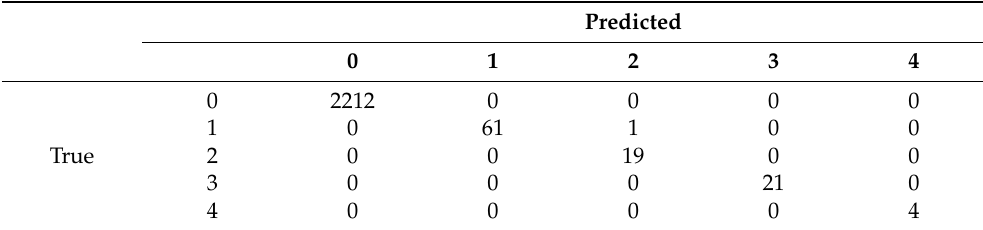
Table 5. Confusion matrix of test